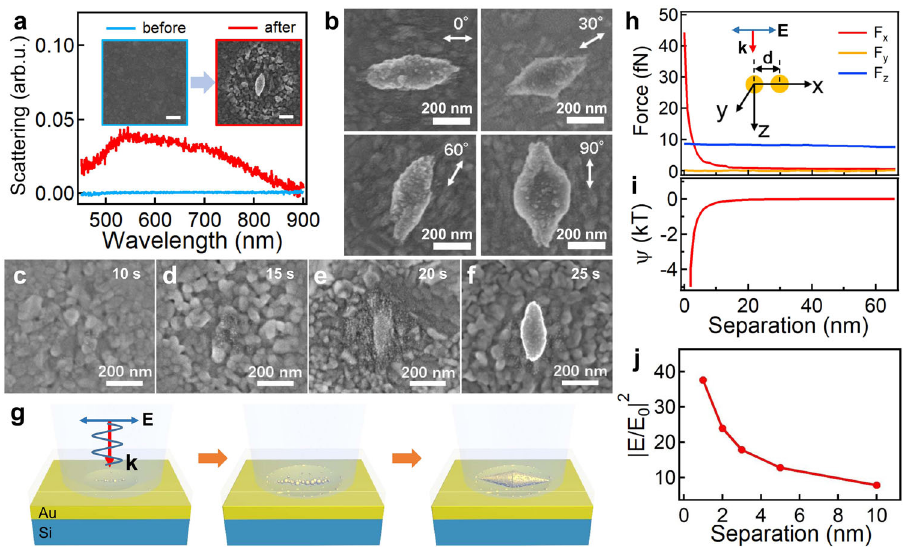
Fig. 2 | Polarization-directed oriented growth ofAu nanospindles. a Change of DF scattering spectra before and after irradiation with 446nm CW laser (4mW, 15s). Insets are the corresponding SEM images, scale bars are 200nm. b SEM images of Au nanospindles with orientation changing with the direction of polar- ization. c – f Evolution of Au nanospindles with time of irradiation. g Schematic of